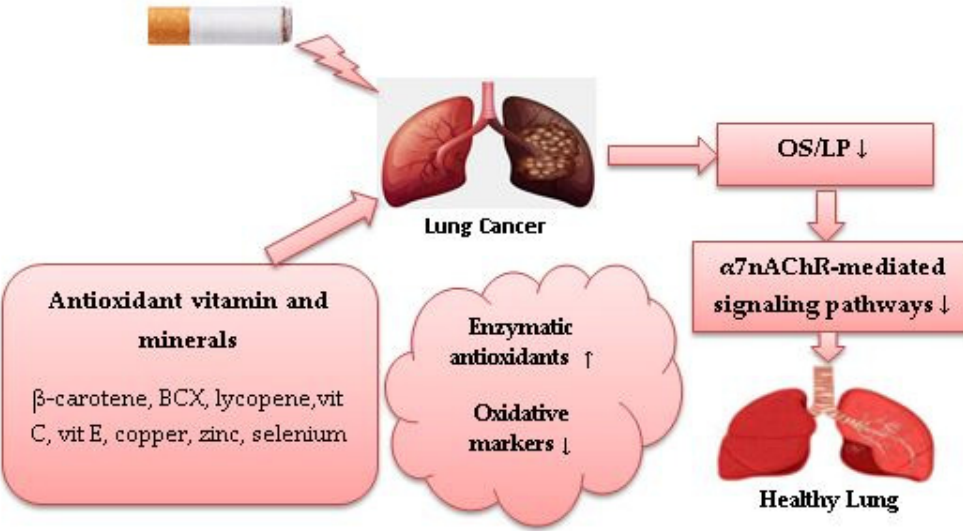
Figure 2. Role of dietary antioxidants against cigarette smoke-induced oxidative stress in lung cancer. ( ↓ ) decrease, ( ↑ )